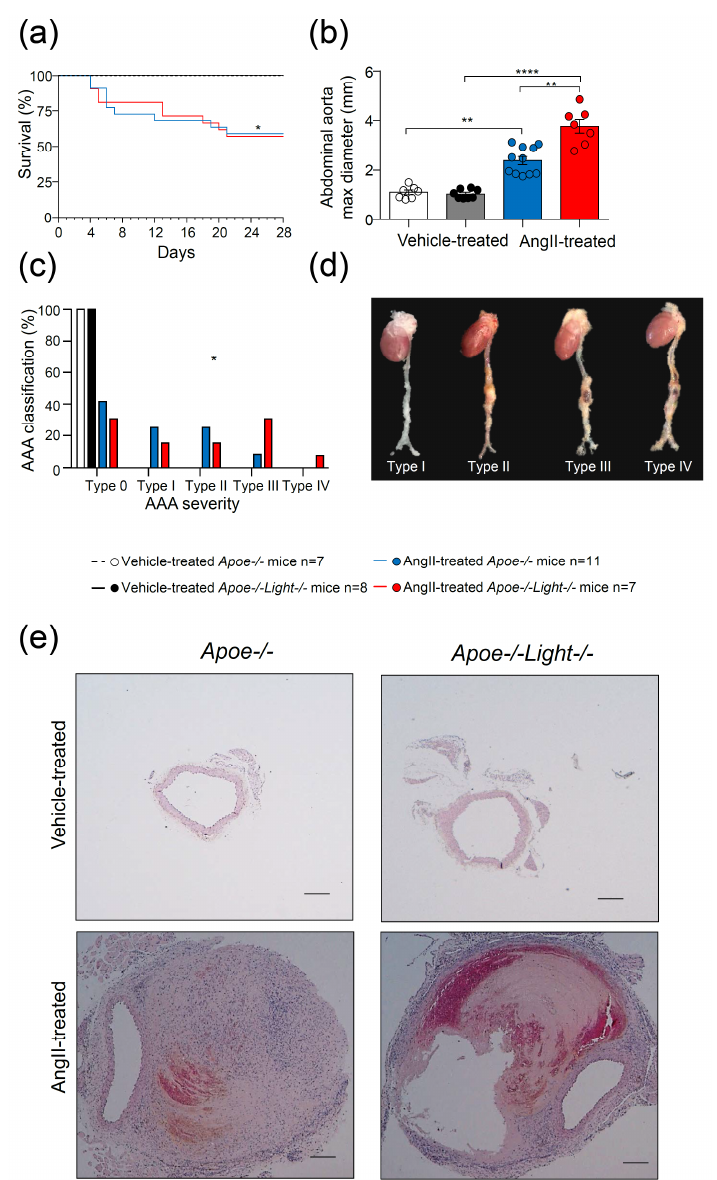
Figure 1. AngII–induced dissecting AAA analysis in Apoe − / − and Apoe − / − Light − / − mice. ( a ) Sur- vival curves for vehicle- and AngII-treated mice. ( b ) Comparison of suprarenal abdominal aorta maximal diameter among groups. ( c ) AngII–induced dissecting AAA severity distribution in all four groups of mice. ( d ) Representative images of whole aortas with AngII–induced dissecting AAA classified by severity and ( e ) abdominal aortic cross-sections stained with hematoxylin-eosin. Scale bar: 200 µ m. Statistical analysis was: Long-rank (Mantel-Cox) test ( a ), two-way ANOVA followed by Tukey’s multiple comparison test ( b ), and Chi-square test ( c ). * p ≤ 0.05, ** p < 0.01, and **** p <